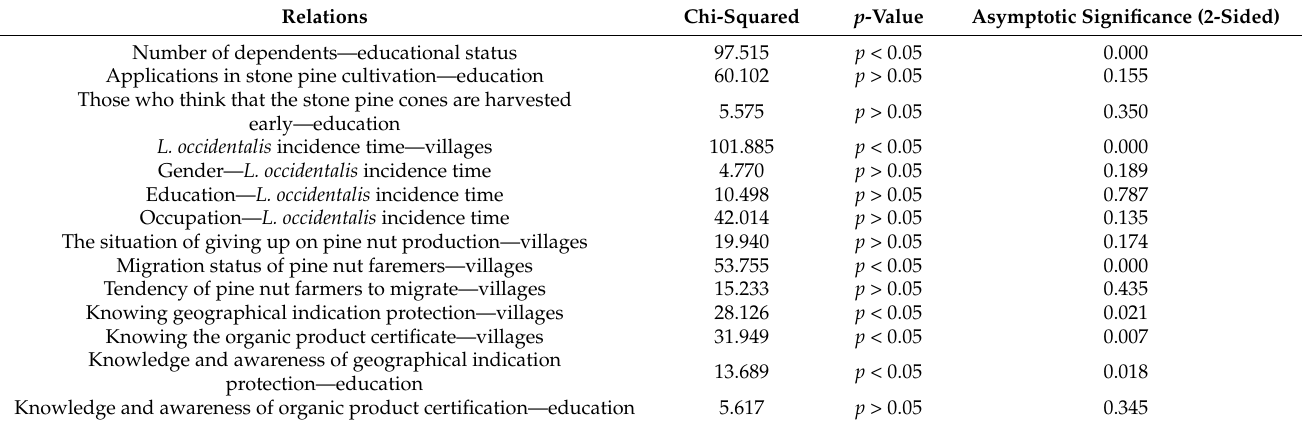
Table 12. Chi-squared test